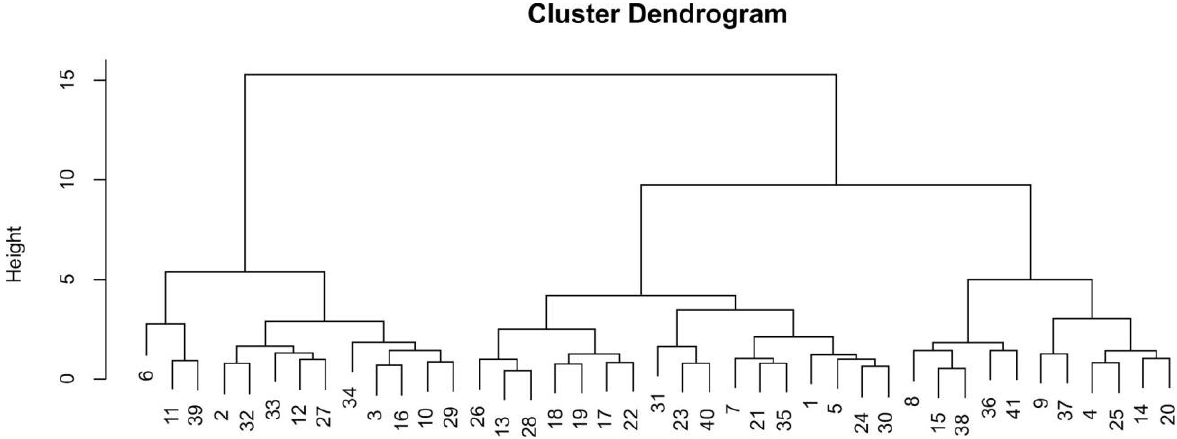
Figure 7. Classification tree for data set 3 (University, Economics) obtained with R package tree.